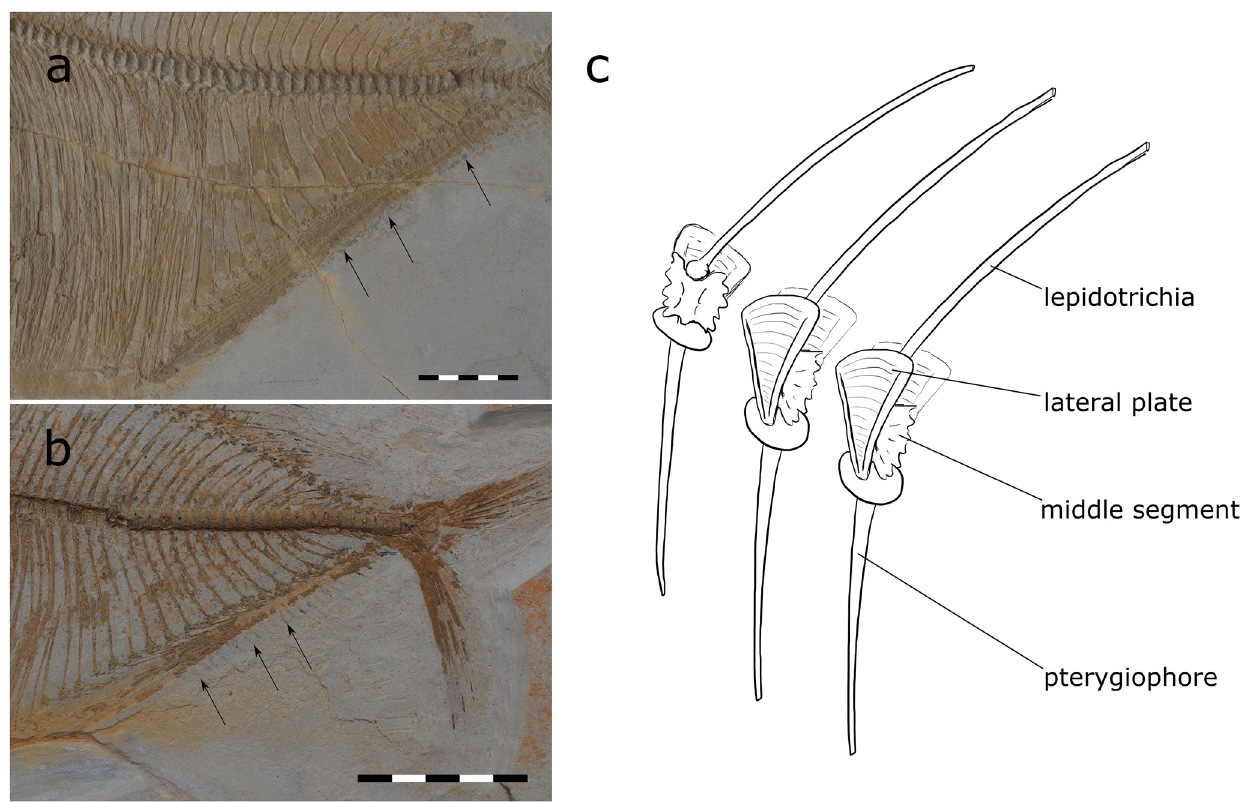
Fig 14. Retraction of the unpaired fins of T . formosa behind lateral plates (A and B) (CPC-2856 and CPC-2885). Reconstruction of the skeletal elements found in the unpaired fins (C). All scales 50 mm.